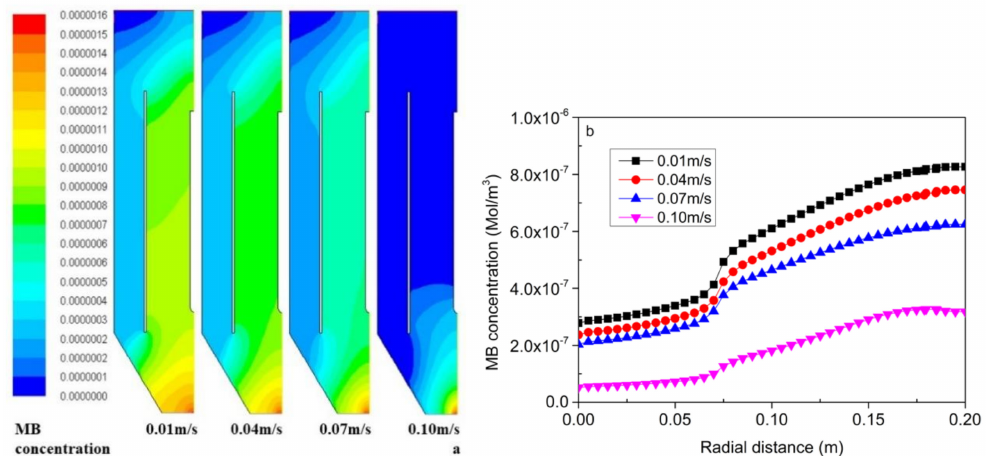
Figure 8. The contours ( a ) and the radial distribution ( b ) of molar concentration of MB at di ff erent gas velocities in Section